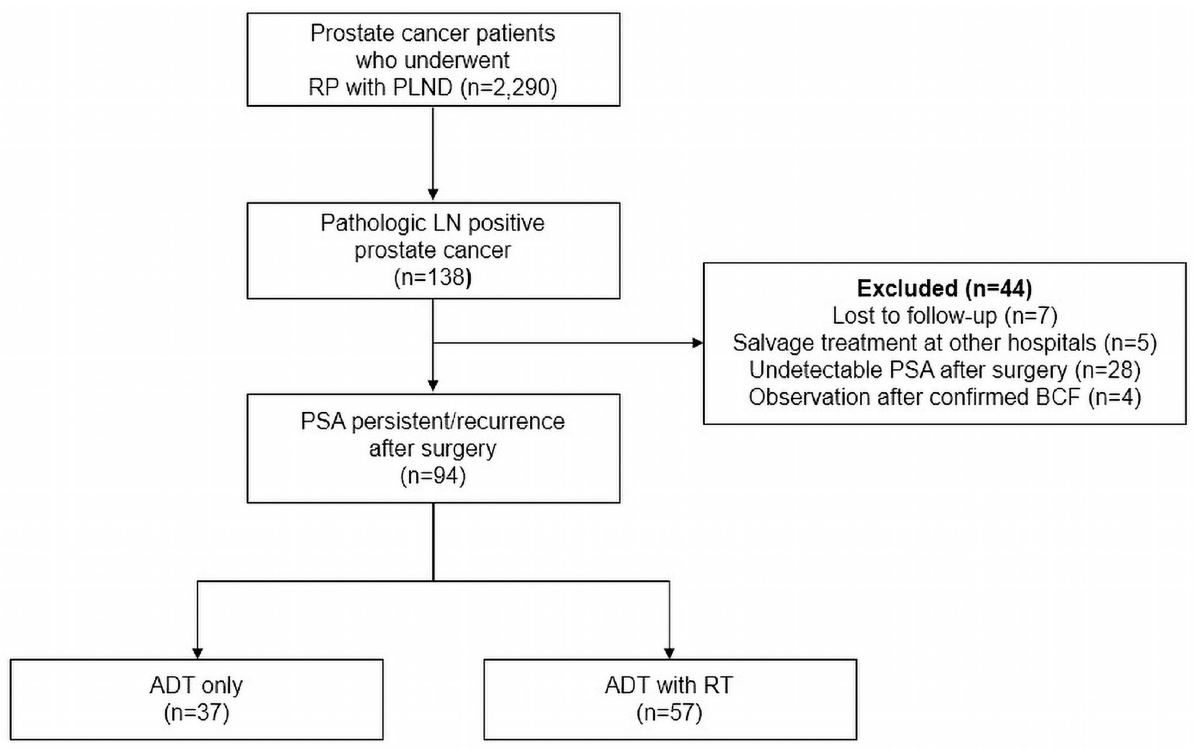
Fig 1. Flowchart of included and excluded patients and group assignments. Abbreviations: ADT, androgen deprivation therapy; LN, lymph node; PLND, pelvic lymph node dissection; PSA, prostate-specific antigen; RP, radical prostatectomy; RT, radiotherapy.